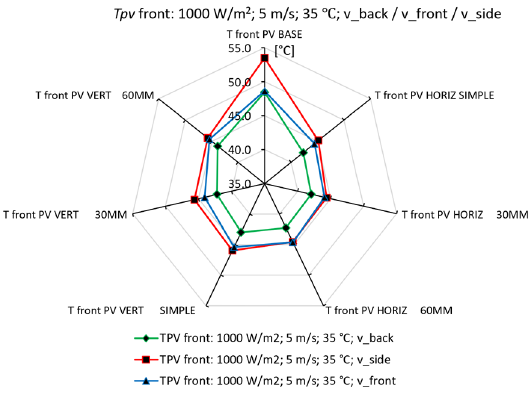
Figure 10. Variation of average operating temperature for v air = 5 m/s.